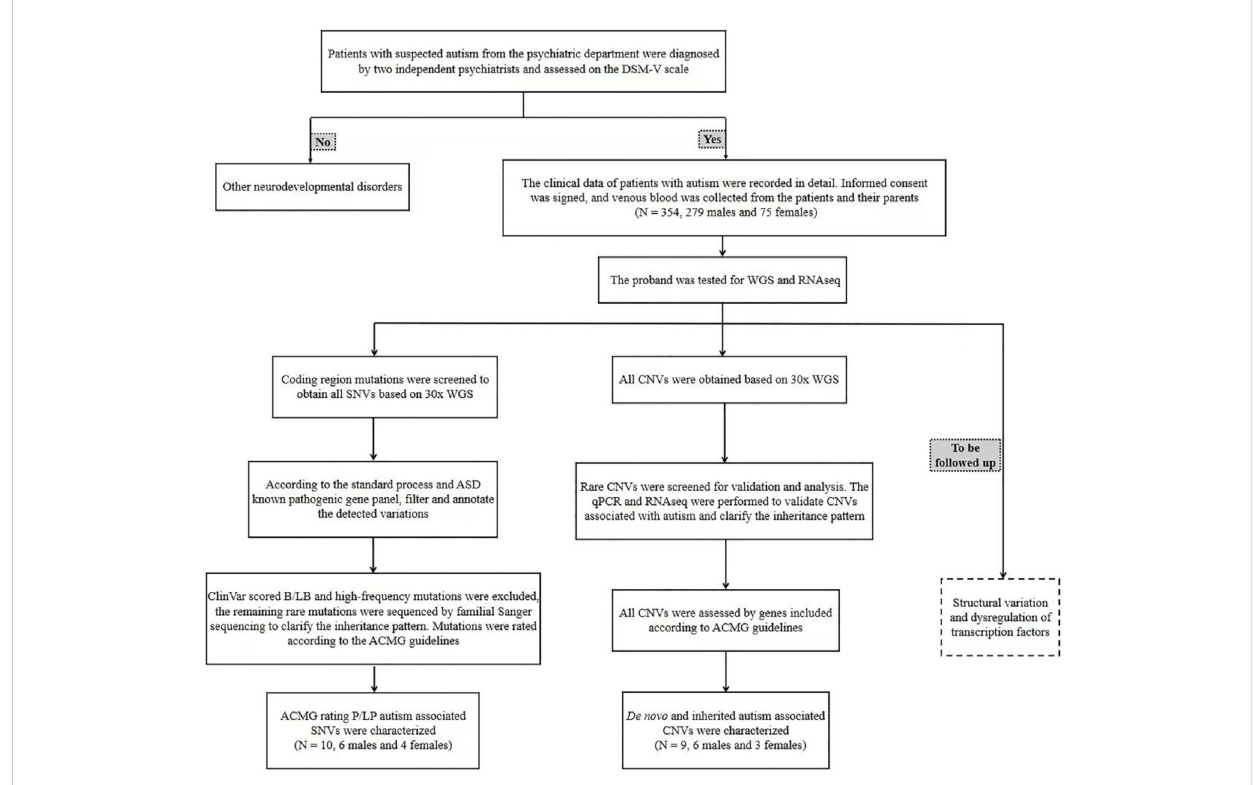
FIGURE 1 The clinical enrollment and diagnosis fl owchart of ASD patients. qPCR: quantitative PCR; WGS: whole genome sequencing; SNV: single nucleotide variation; CNV: copy number variation; RNAseq: RNA